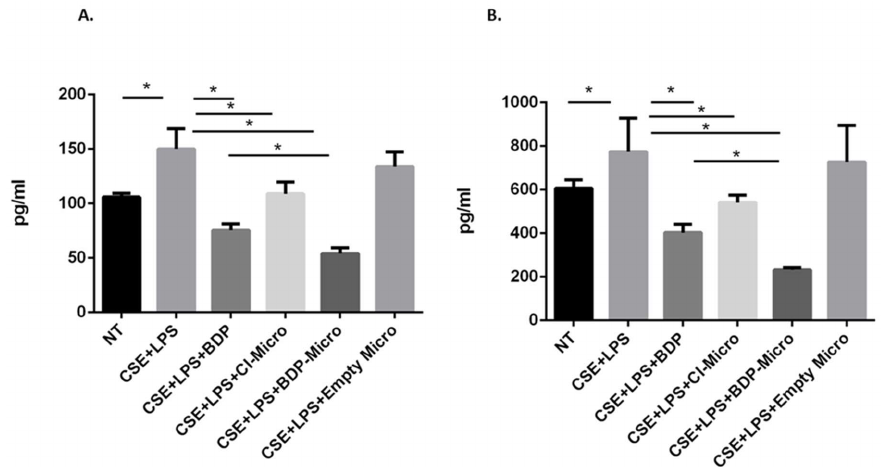
Figure 8. IL-8 release in 16HBE and A549 cells. 16HBE ( A ) and A549 ( B ) cells were incubated for 24 h with either free BDP in dispersion (BDP), with empty particle (Empty Micro) or BDP incorporated into the MP systems (CI-Micro or BDP-Micro) (10 −8 M) and CSE 10% and LPS 1 µg/mL. The drug (free or entrapped into MP samples) was added 1 h before CSE and LPS cell stimulation, then the supernatants were collected for evaluation of IL-8 release by ELISA method assays. Mean values ± standard deviations (error bars) are reported ( n = 5). * p < 0.05 ANOVA